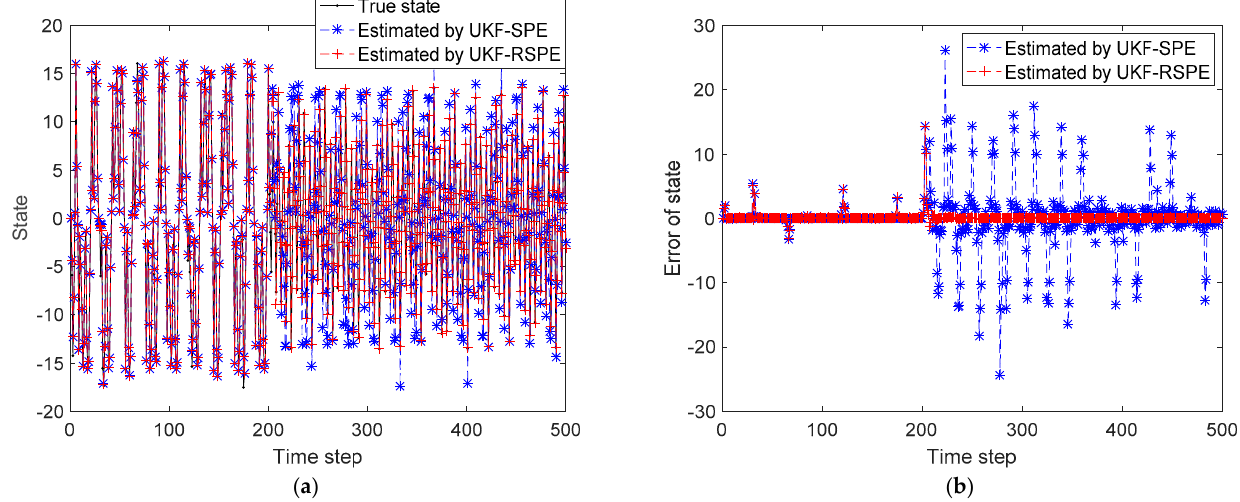
Figure 5. The comparison of the estimated results of the state in Case Study 1: ( a ) estimated state; ( b ) state error.